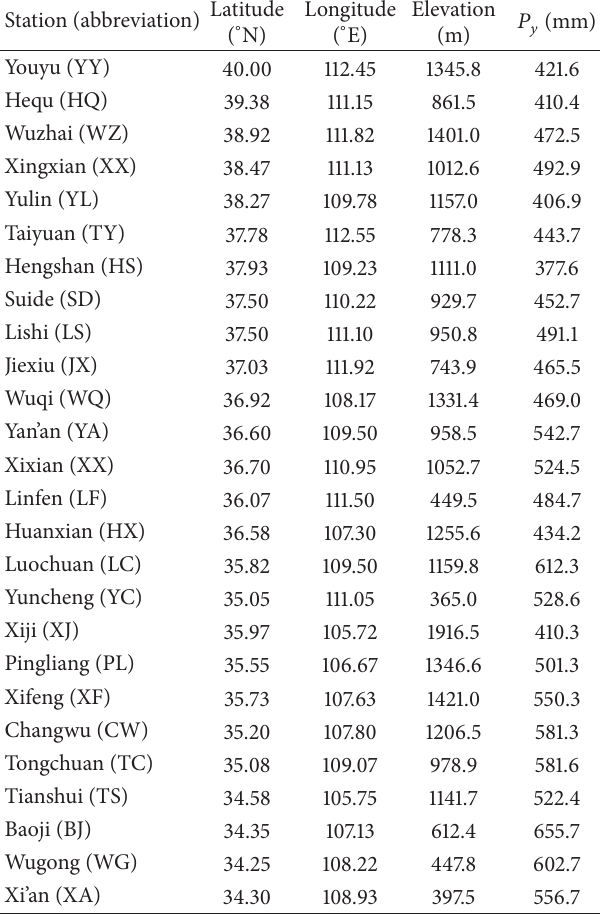
Table 1: Geographical coordinates, annual mean precipitation ( 𝑃 𝑦 ) for 26 meteorological stations across the middle reaches of the Yellow